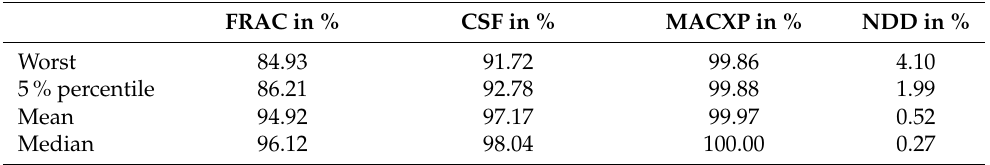
Table 2. Statistics of model performance indicators using the identified stiffness and damping parameters for the case “model vs. ideal model” for three considered axis positions z 2 , z 3 , and z 4 .